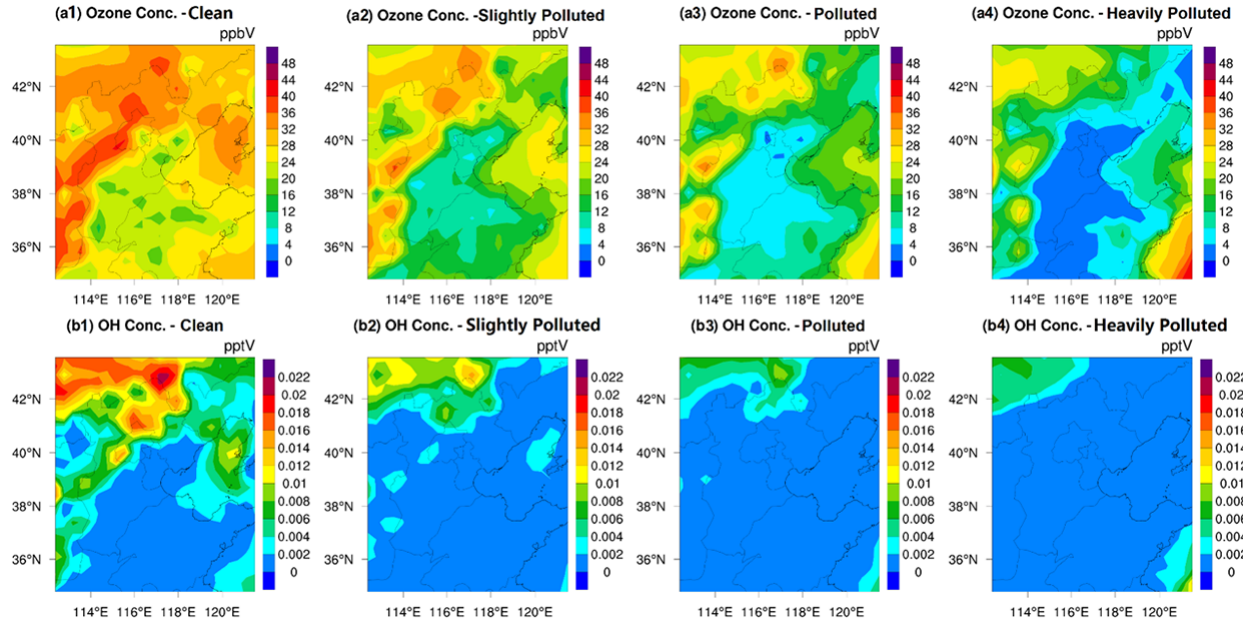
Figure 8. Revised WRF-CMAQ simulated regional distribution of daytime (07:00 ∼ 18:00) concentration of (a) O 3 (ppbV) and (b) OH (pptV) at different pollution